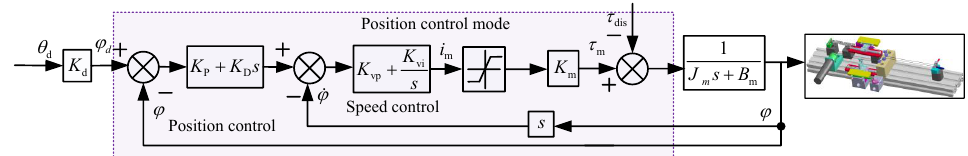
Figure 8. Control block diagram of the parameter identification for the joint angle estimator.